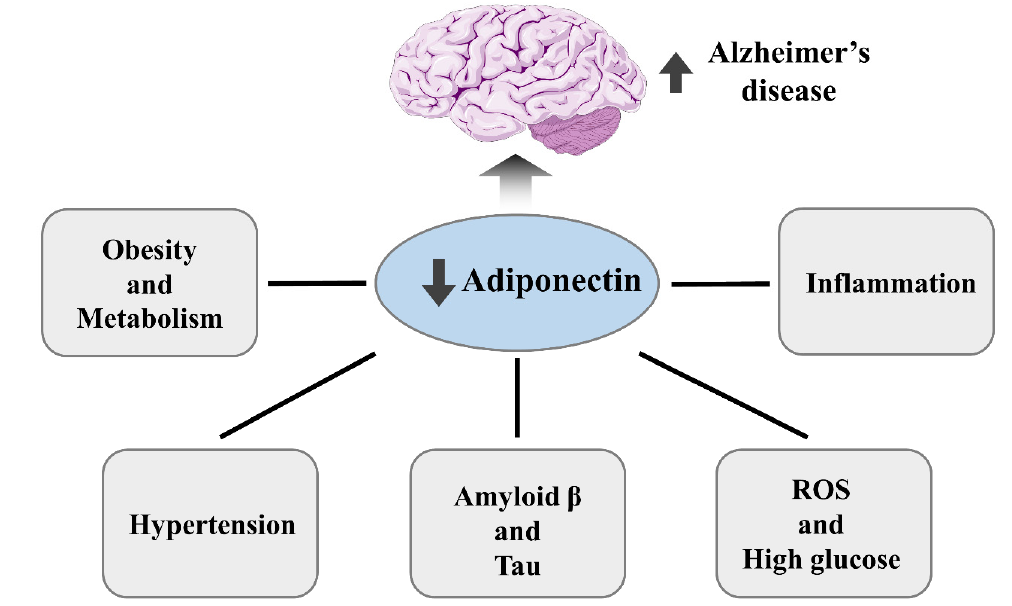
Figure 2. Downregulation of adiponectin involved in the mechanism of Alzheimer’s disease exacerbates AD pathology and impairment.